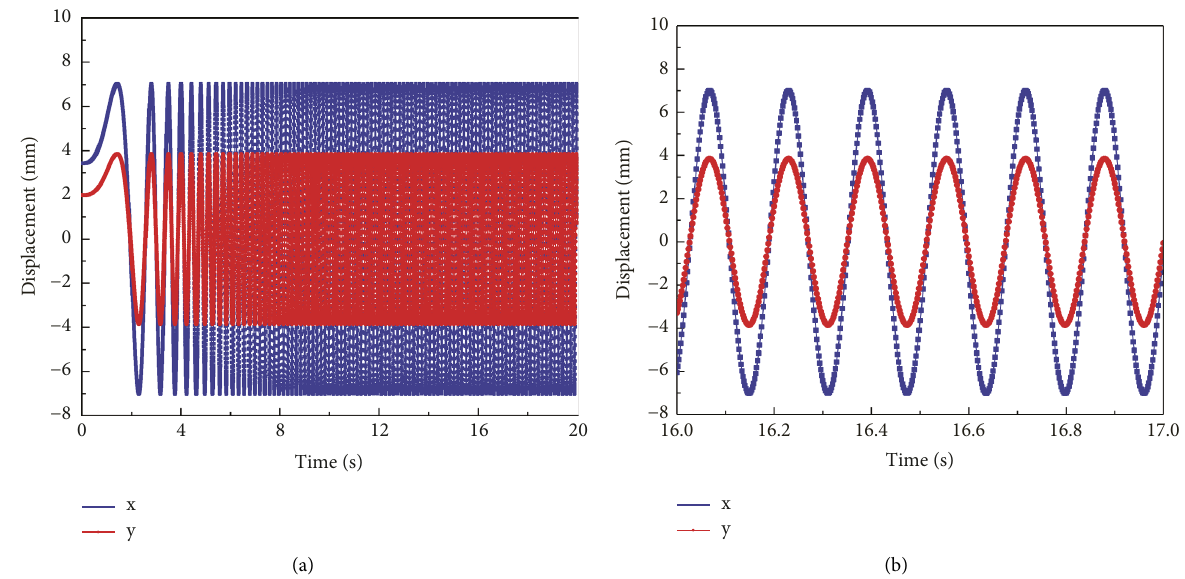
Figure 4: Time-responses of the displacement about the NCDS.